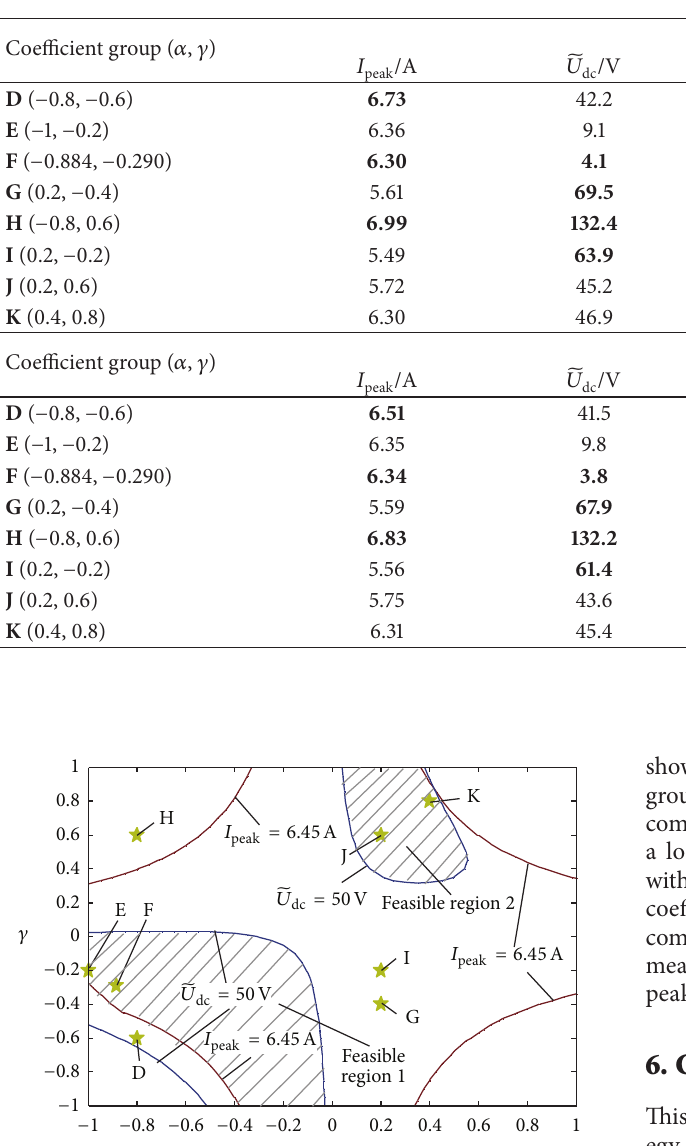
Table 2: Comparison between calculation and simulation results for different power control coefficients.